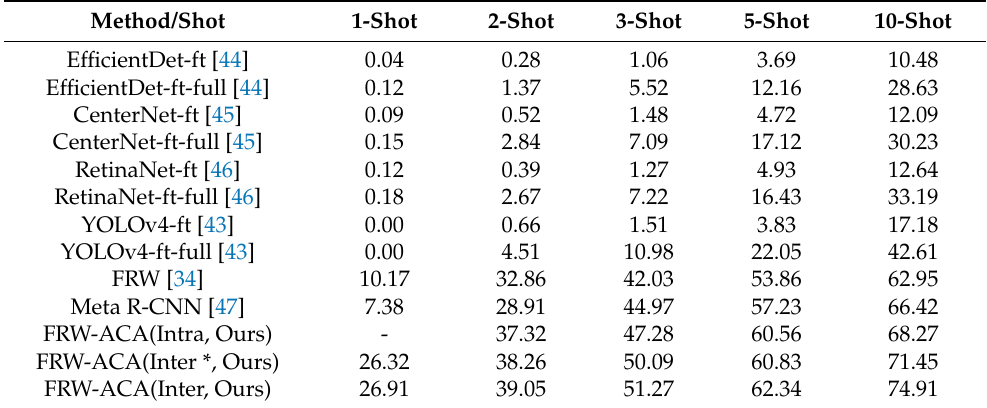
Table 2. Few-shot detection performance (mAP) for cross-dataset evaluation. (* indicates remove spatial constraints in the